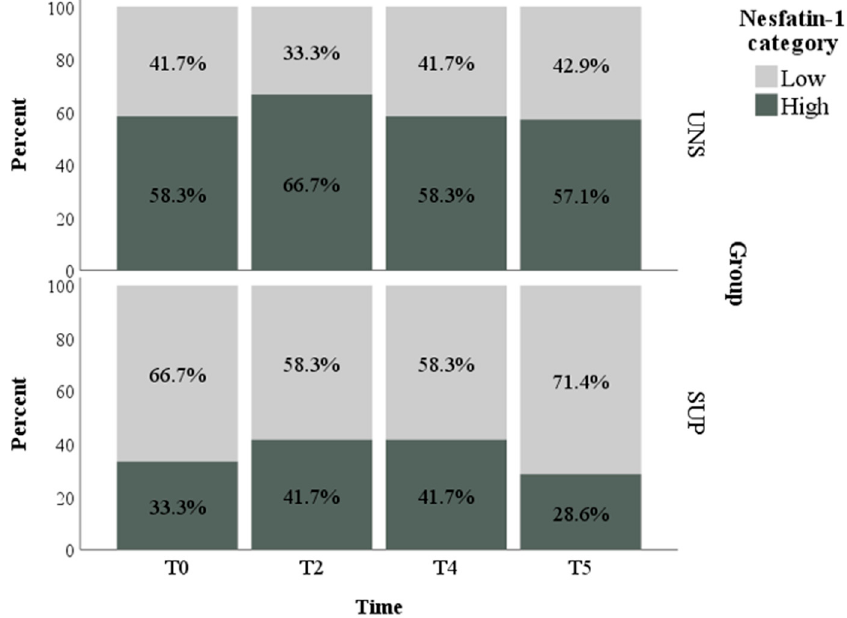
Figure 2. Relative frequencies of Nesfatin-1 categorized into “low” and “high levels” according to group (UNS = control ewes, SUP = supplemented ewes) and time (T0 = before the administration of supplementation; T2 = 20th day of supplementation; T4 = 40th day of supplementation; T5 = 50th day of supplementation).